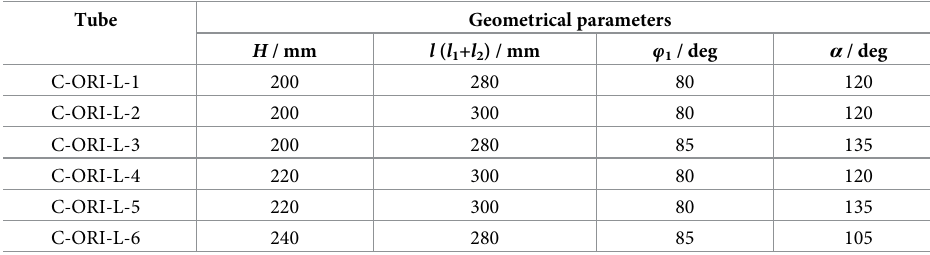
Table 3. Modelling information of patterned